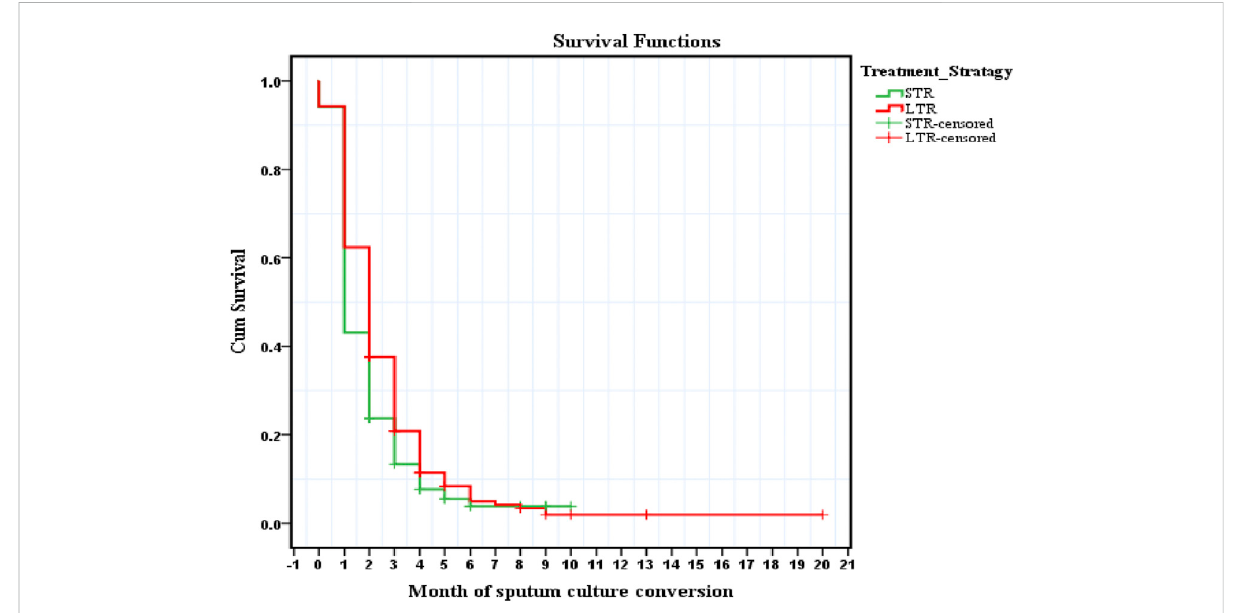
FIGURE 2 Time to sputum culture conversion among MDR-TB patients receiving Longer and Shorter treatment